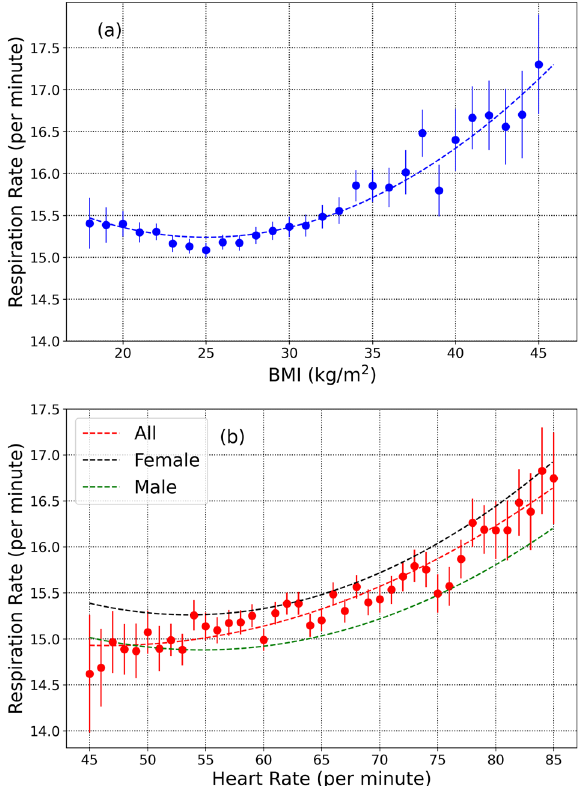
Fig. 3 Variation of respiratory rate with BMI and heart rate. a Respiratory rate dependence on BMI. The lowest value occurs at a BMI of ~25. b Respiratory rate variation with nocturnal heart rate measured in non-REM sleep (black and green curves are for females and males, respectively, the red curve is for all participants). Error bars show the standard error of the